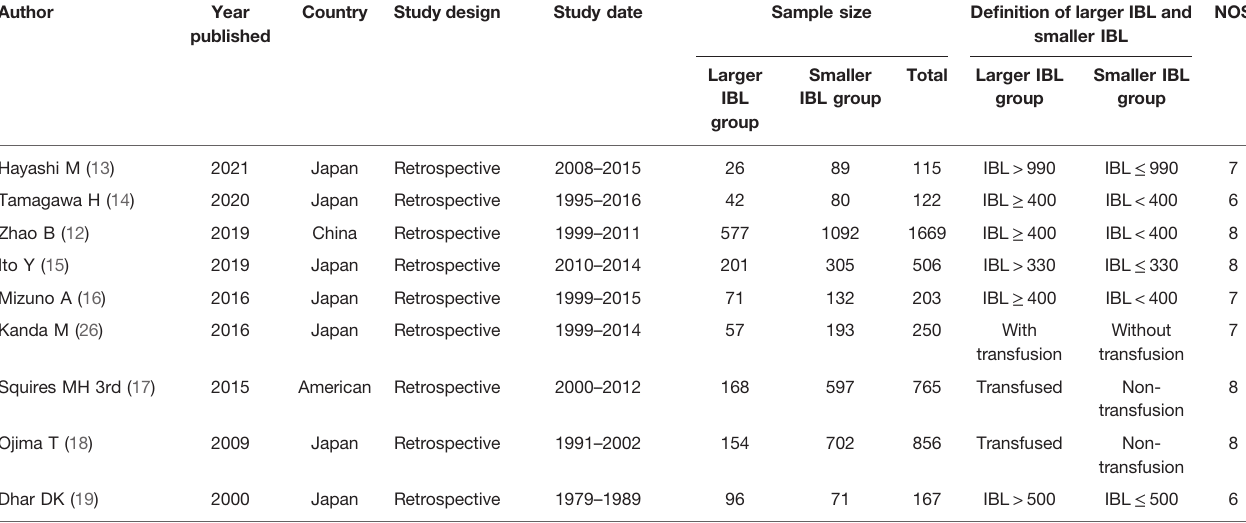
TABLE 1 | Characteristics of the studies included in the